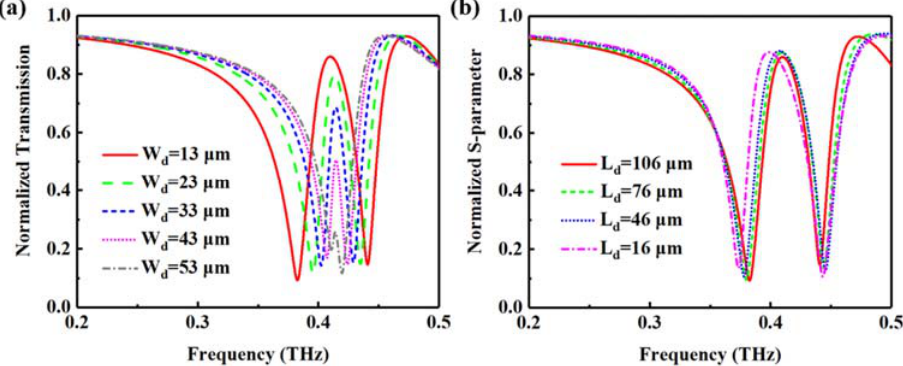
Figure 6. Normalized transmission spectra of the proposed EIT MTM with ( a ) different horizontal coupling distance W d from 13 to 53 µ m and ( b ) different vertical coupling distance L d from 16 to 106 µ m.